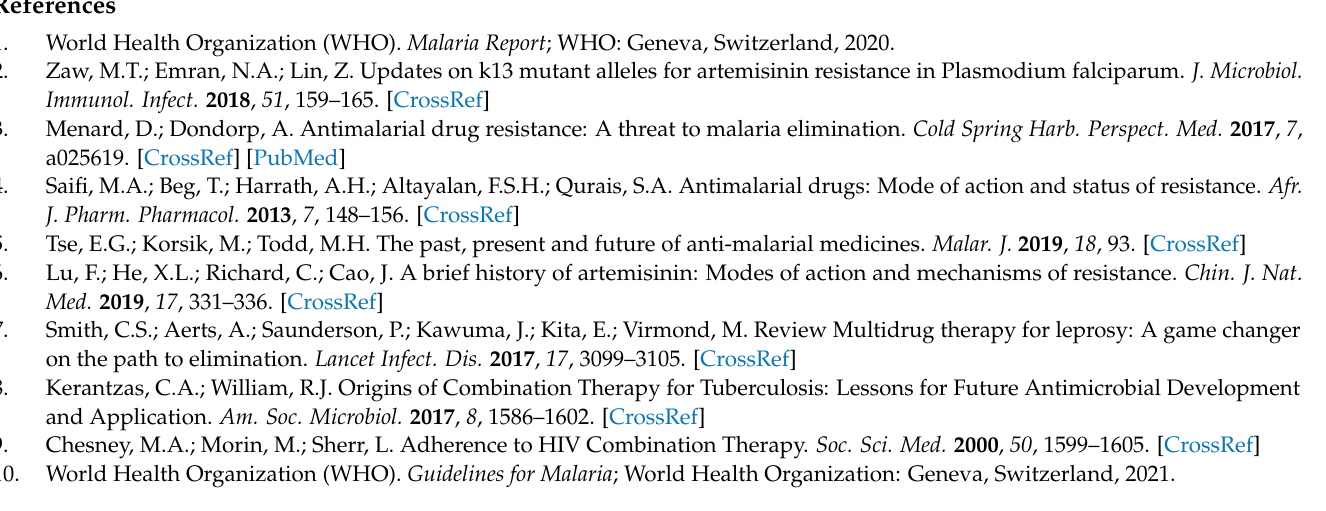
samples received from nearby hospitals for ex vivo testings. Figure S5; Red blood cells, drug-extract combinations, P. falciparum strains, and test media in 96-well plate. Table S1; Relative fluorescence strain. Table S2; Relative fluorescence units and sum FIC 50 s for artemether combined with leaves extract against field isolate ex vivo. Table S3 (excel); Molecular analysis